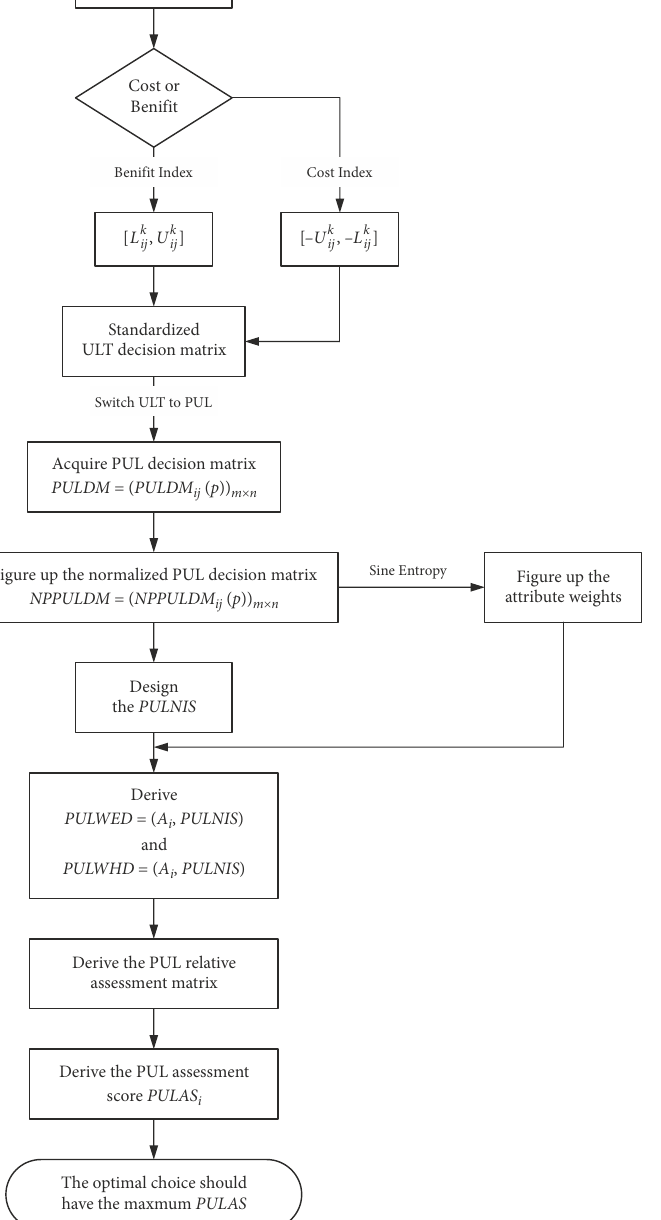
Figure up the normalized PUL decision matrix NPPULDM = ( NPPULDM ( p ))